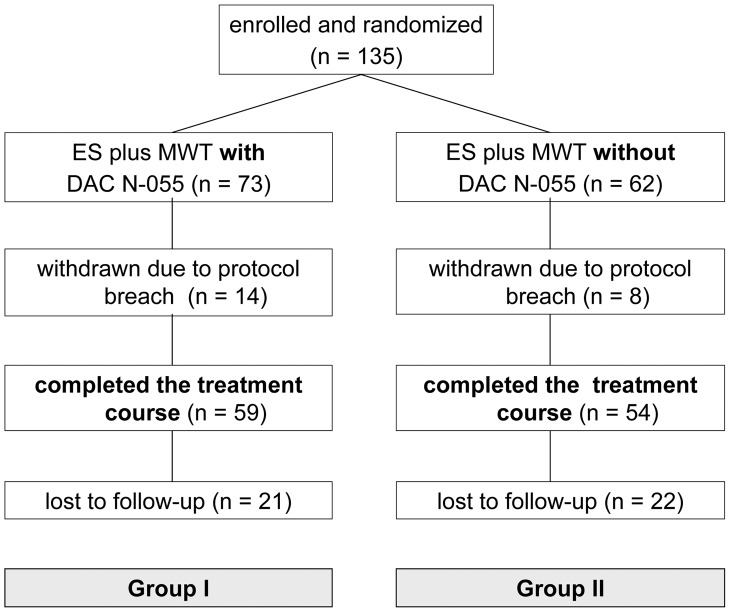
Study flow diagram showing the enrolment, randomization and follow-up of patients (CONSORT flow chart).